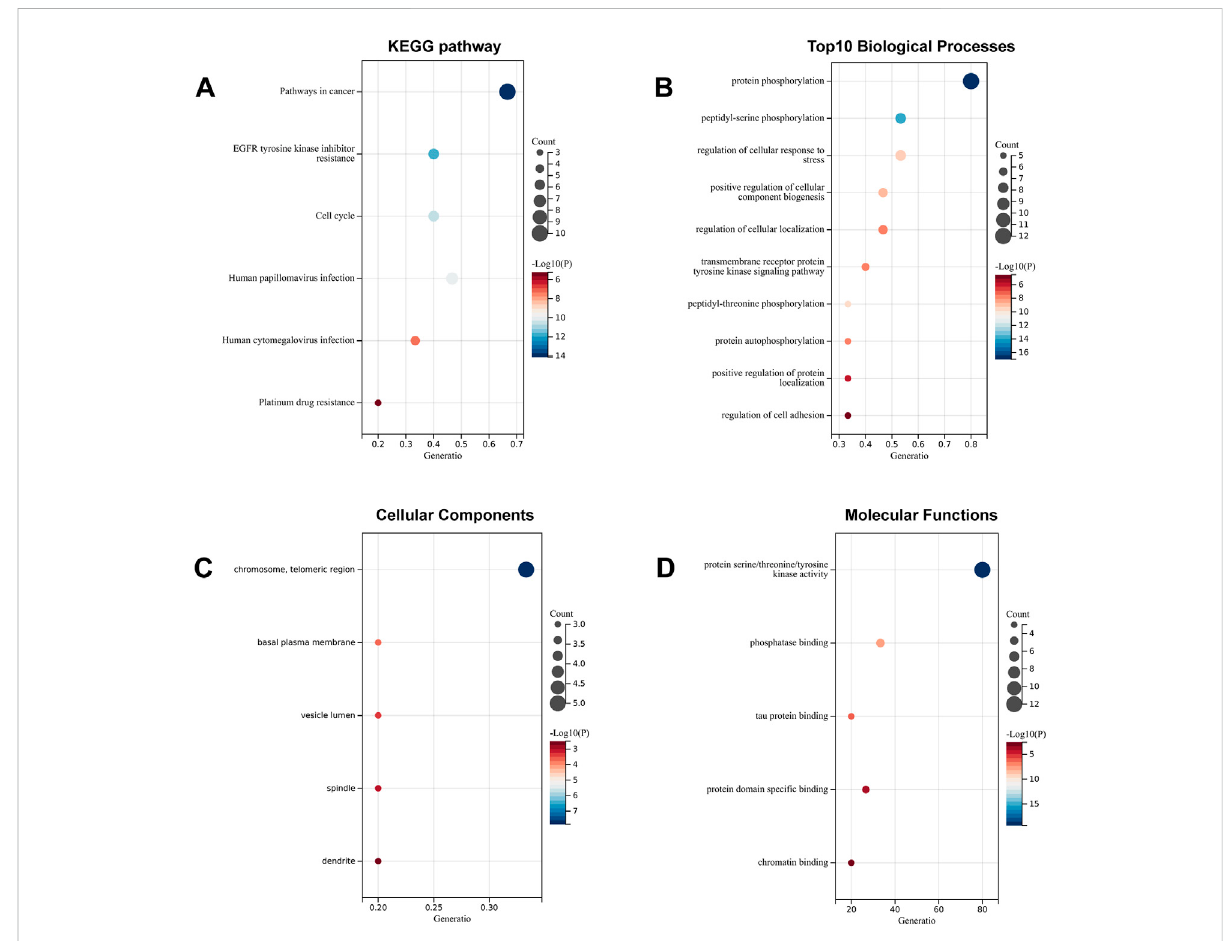
FIGURE 7 Functional analysis of SchB targets on SARS-CoV-2_hepatitis. (A) The enriched KEGG pathways of genes SchB targets on SARS-CoV- 2_hepatitis. (B – D) The top 10 enriched terms of biological process, cellular component, and molecular